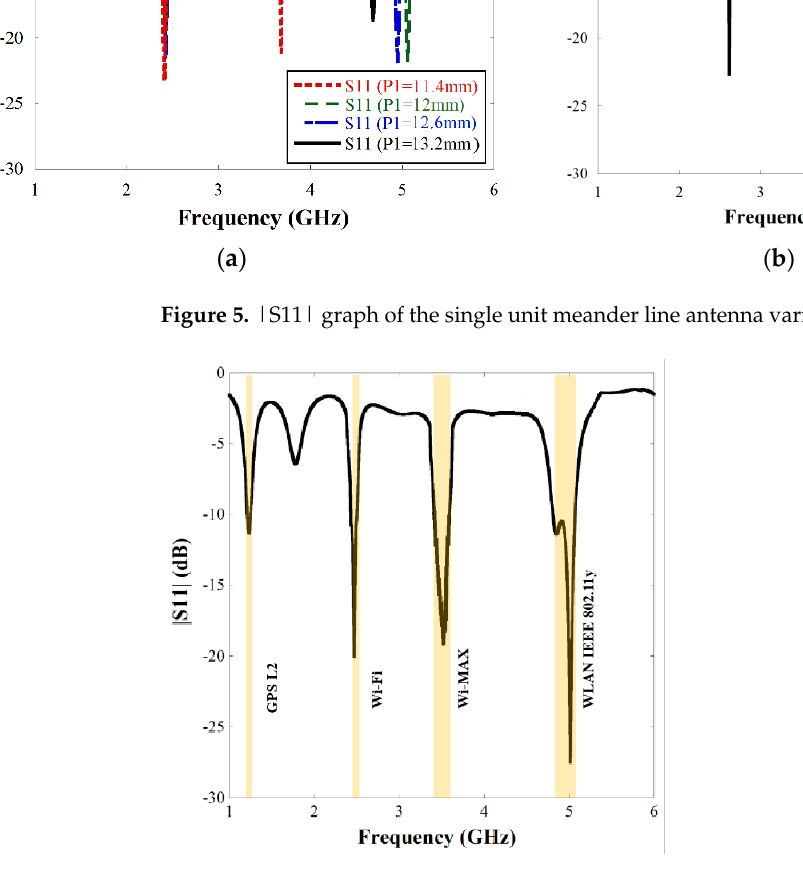
Figure 5. |S11| graph of the single unit meander line antenna variation of length of ( a ) P 1 and ( b ) P 5 .